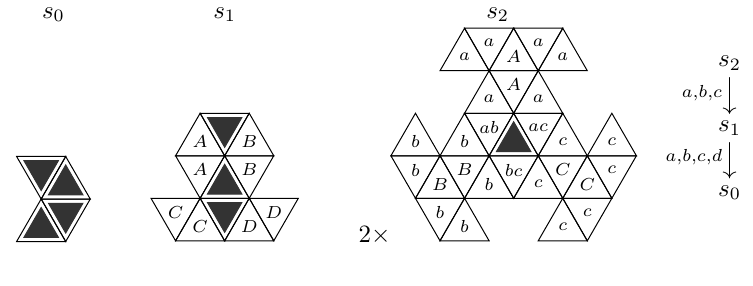
Figure 9: A (2 , 3) proof sequence for T 4 , 2 .